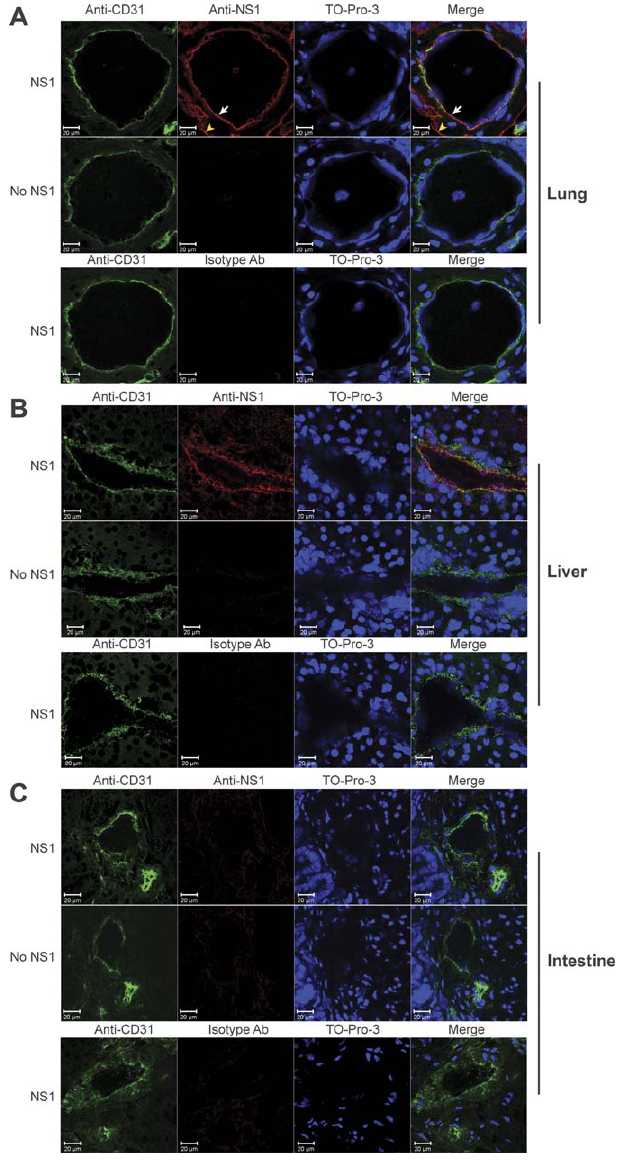
Figure 8. Binding of DENV NS1 to Mouse Tissues Cryo-sections of mouse (A) lung, (B) liver, and (C) intestine were incubated with serum-free supernatants from BHK DENV-2 Rep or BHK cells for 1 h at room temperature. After extensive washing, bound NS1 was detected by a mixture of NS1 mAbs (1A4, 1F11, 2G6, 1B2) followed by Cy3-conjugated goat anti-mouse IgG. Co-staining with endothelial cell marker was subsequently performed by incubating the sections with rat anti-mouse CD31 (PECAM-1) followed by Alexa Fluor 488-conjugated goat anti-rat IgG. Nuclei were stained with a DNA-specific dye TO-PRO-3. Sections incubated with DENV NS1 followed by an isotype control Ab served as a negative control. Analysis was performed by confocal microscopy. White arrow and yellow arrowhead denote the layer of endothelial cells in the lumen and the outer layer of the adventitia of pulmonary vessel, respectively. doi:10.1371/journal.ppat.0030183.g008 salt gradient (0–1 M NaCl) over 20-column volumes at 1 ml/min. Purity and immunoreactivity of DENV NS1 were confirmed by SDS- PAGE with silver staining and western blot. Concentrations of purified protein were determined by the bicinchoninic acid assay. Purified DENV NS1 from DENV-infected mammalian cells was obtained as previously described [28]. DENV NS1 binding to cells. Adherent cells were removed from PLoS Pathogens |